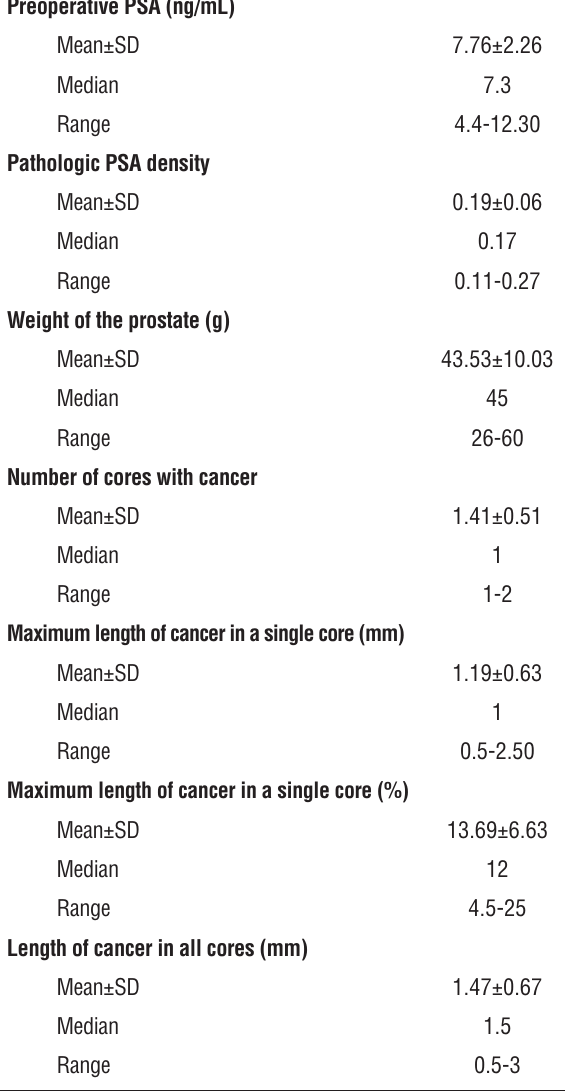
Table 1 - Clinicopathologic findings on the correspondent needle biopsies of 17 patients submitted to radical prostatectomy with insignificant cancer in the surgical